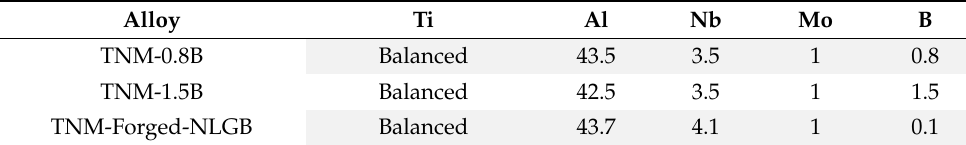
Table 1. Nominal chemical composition in at.% of the modified TNM alloys. Alloy Ti Al Nb Mo B TNM-0.8B Balanced 43.5 3.5 1 0.8 TNM-1.5B Balanced 42.5 3.5 1 1.5 TNM-Forged-NLGB Balanced 43.7 4.1 1